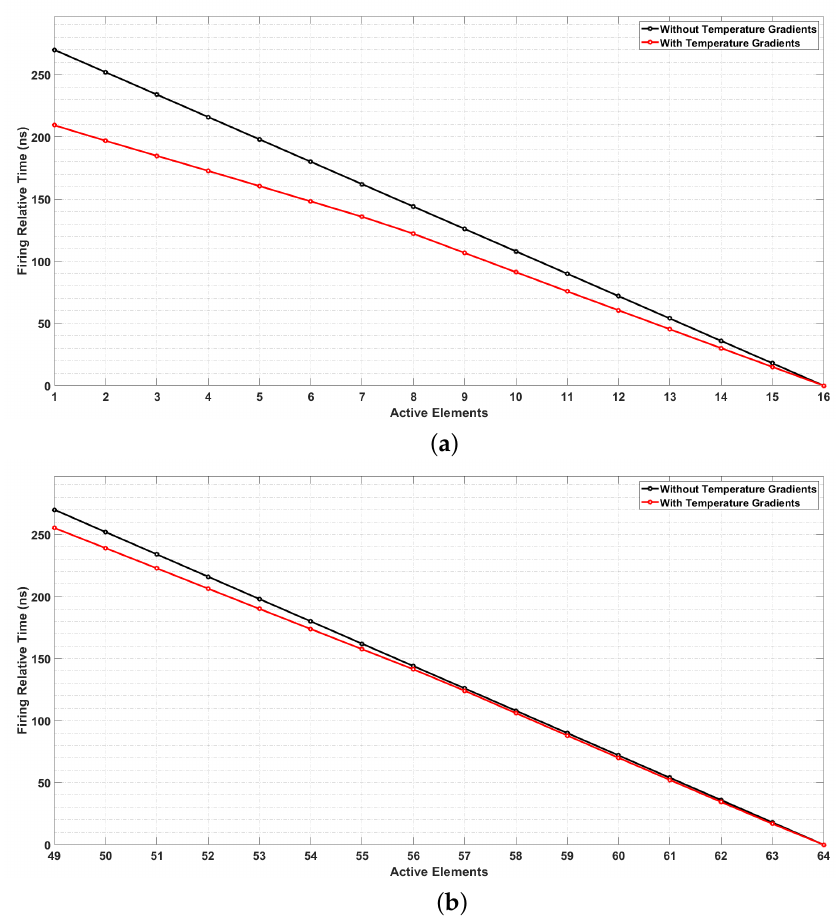
Figure 10. Focal Laws defined for generating a plane wave with an angle of refraction 40 ◦ in inspection procedures with and without temperature gradients along the sonic path. Wavefront formed ( a ) using the first 16 active elements of the PA transducer and ( b ) using the last 16 active elements of the PA